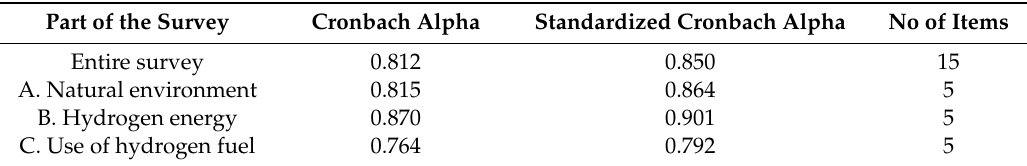
Table 4. Cronbach Alpha coe ffi cients (own